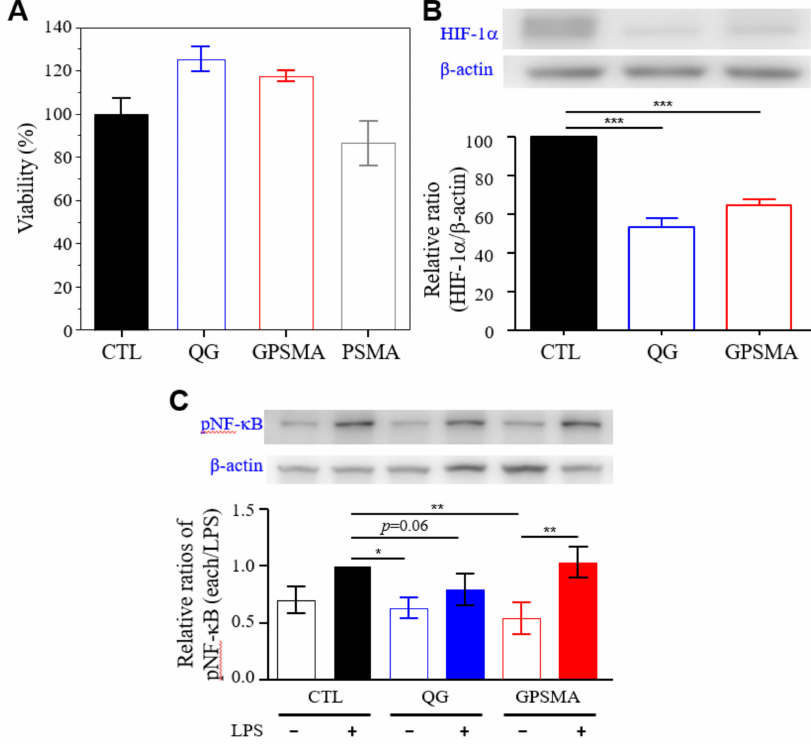
Figure 5. In vitro assessments of QG and GPSMA. ( A ) The viability of cells treated with QG, PSMA, and GPSMA in normoxic environments for 24 h. ( B ) Western blot analyses for the protein expression of HIF-1 α in dermal fibroblasts under hypoxic conditions after being cocultured for 1 day ( n = 3) and ( C ) the relative pNF- κ B expression in RAW 264.7 cells in the absence or presence of LPSs. Both dermal fibroblasts and RAW 264.7 cells were treated with QG and GPSMA. Data are reported as the mean ± SD ( n = 3); * indicates a significant di ff erence between samples (* p < 0.05; ** p < 0.01; *** p < 0.001) using one-way ANOVA with Tukey’s multiple comparisons test. The p -value of QG + LPSs compared to LPSs was 0.0647, according to an unpaired